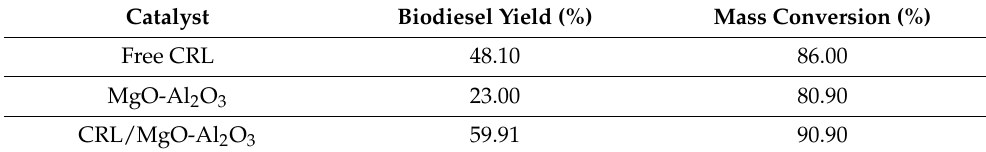
Table 7. Biodiesel production using free CRL, MgO-Al 2 O 3, and CRL-MgO-Al 2 O 3 , respectively.